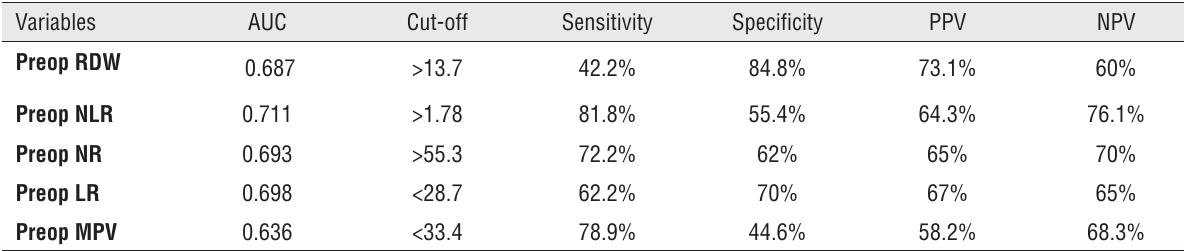
Table 3 - Optimal cut-off values and ROC analyses for LR, NR, RDW, MPV and NLR. Variables AUC Cut-off